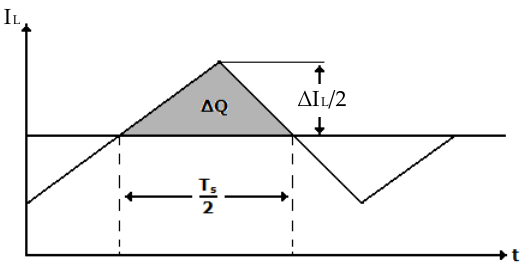
Figure 5. Time variation of the current in the inductor.